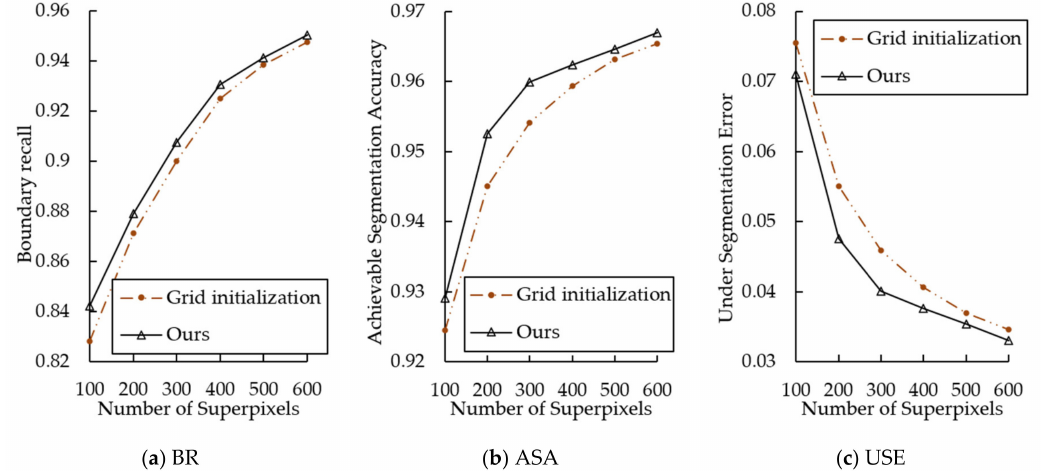
Figure 10. The metrics value comparison of our seed sampling strategy and grid